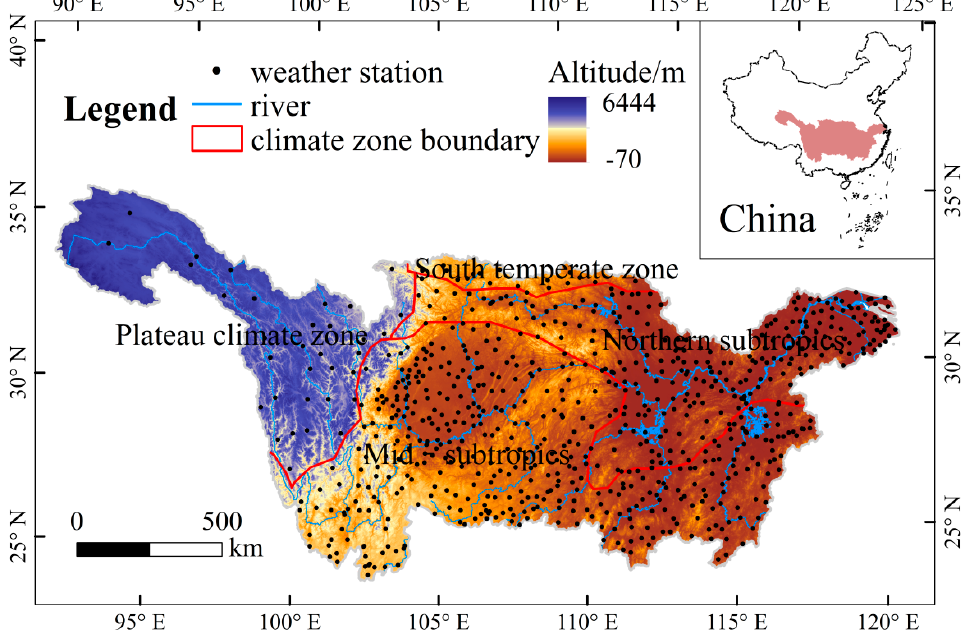
Figure 1. Spatial distribution of weather stations in the Yangtze River Basin.